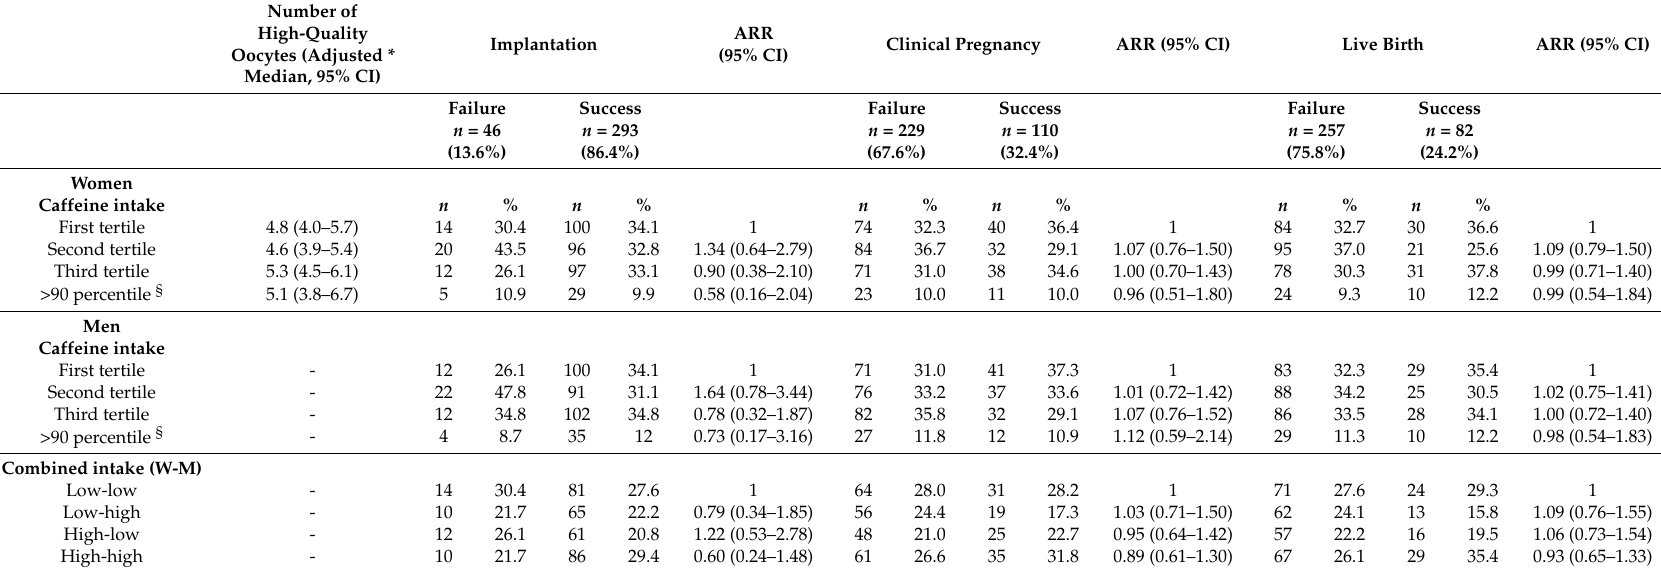
Table 2. Rate ratios for failure of assisted reproduction technique (ART)